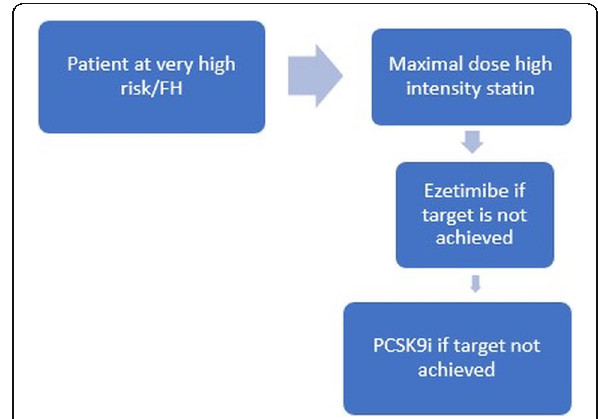
Fig. 1 Proposed algorithm for the starting of PCSK9 inhibitors in very high-risk patients and in familial hypercholesterolemia